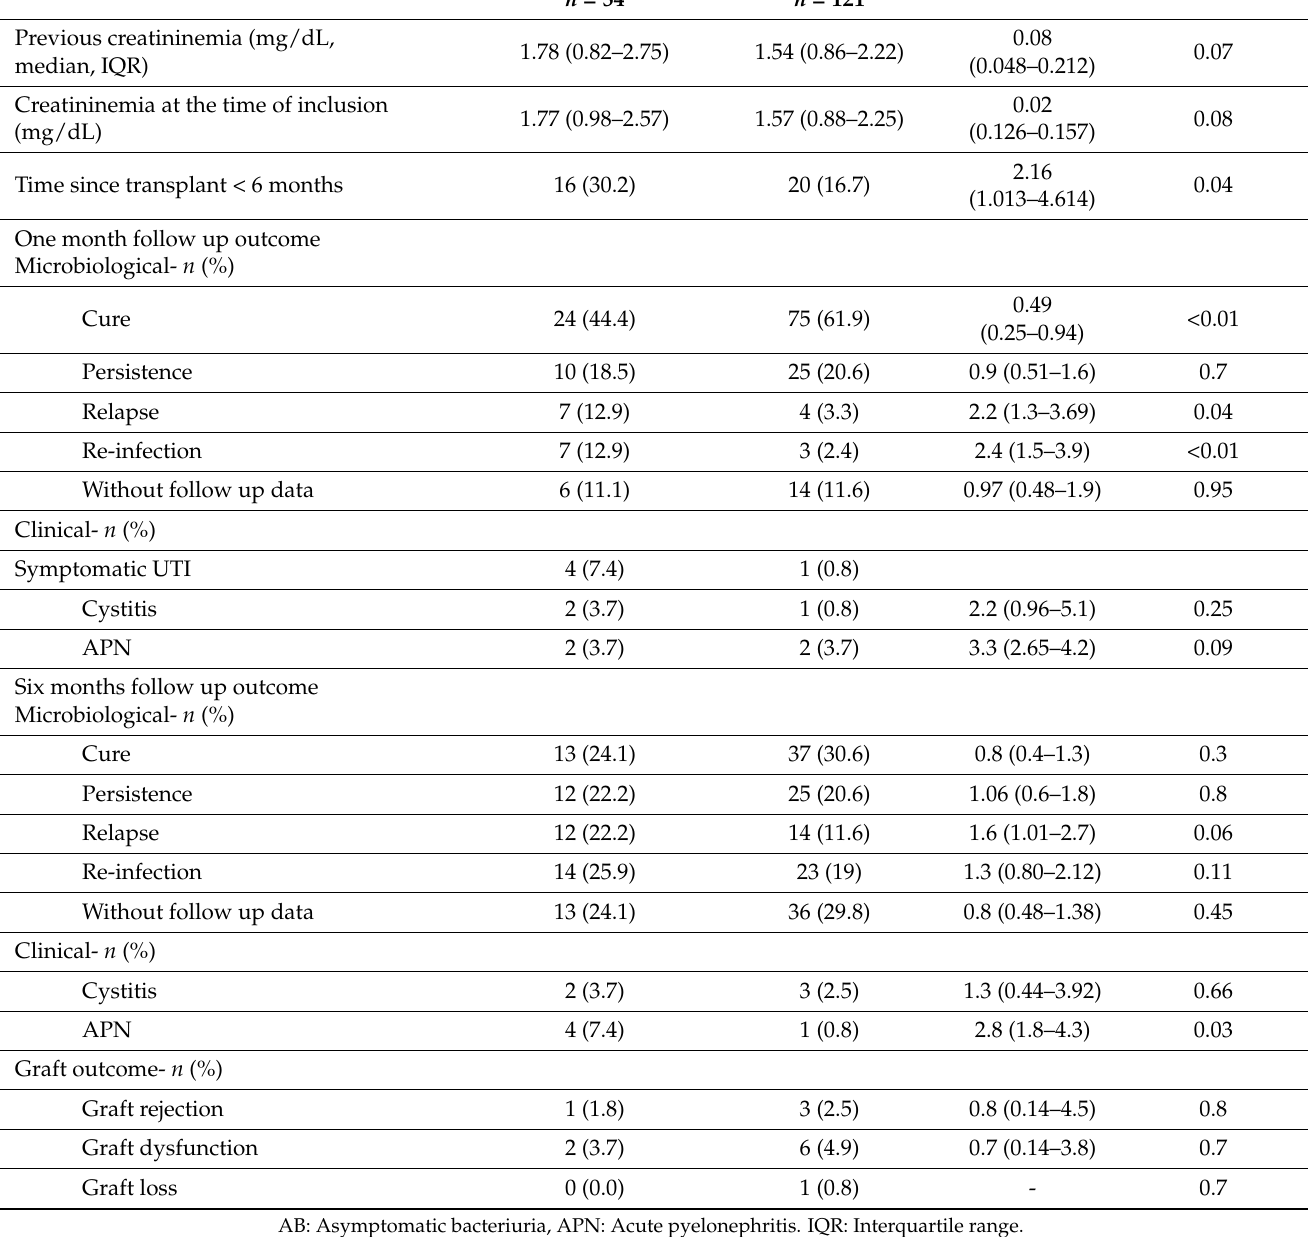
Table 3. Characteristics of treated and untreated patients with asymptomatic bacteriuria.